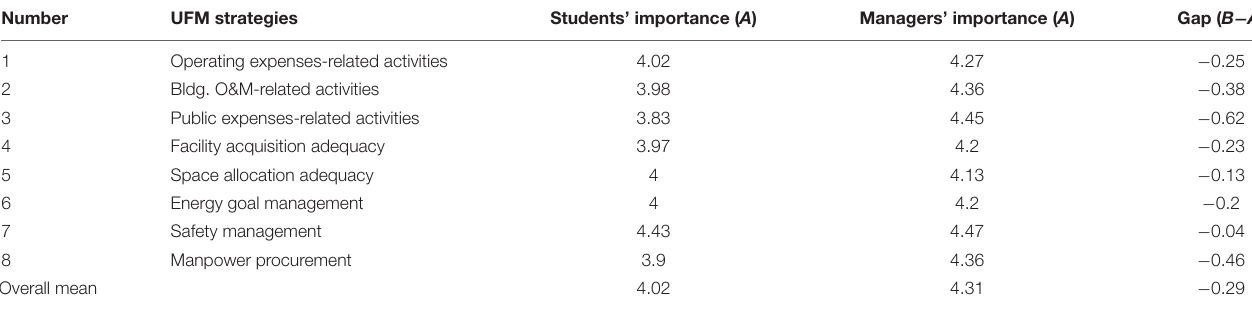
TABLE 6 | Importance differences between students and facility